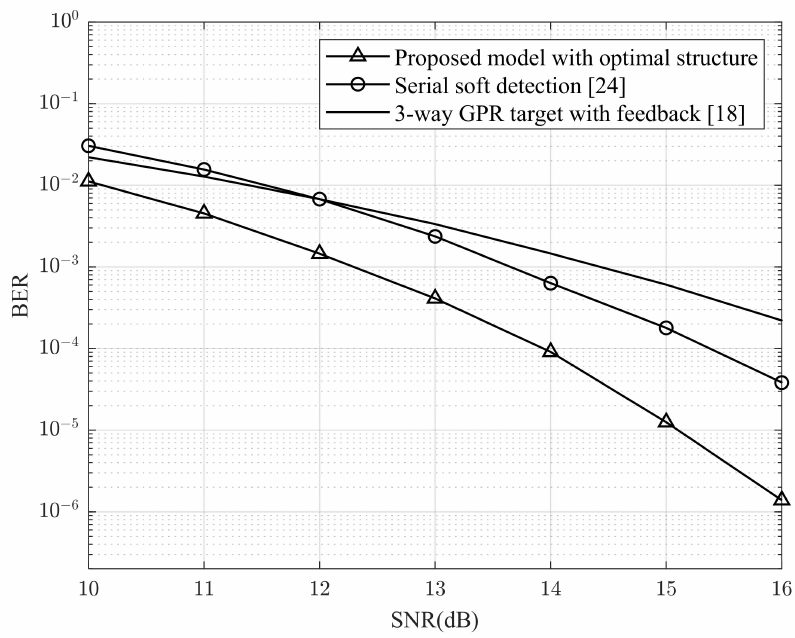
Figure 7. BER performance of the proposed model with 6% position fluctuation